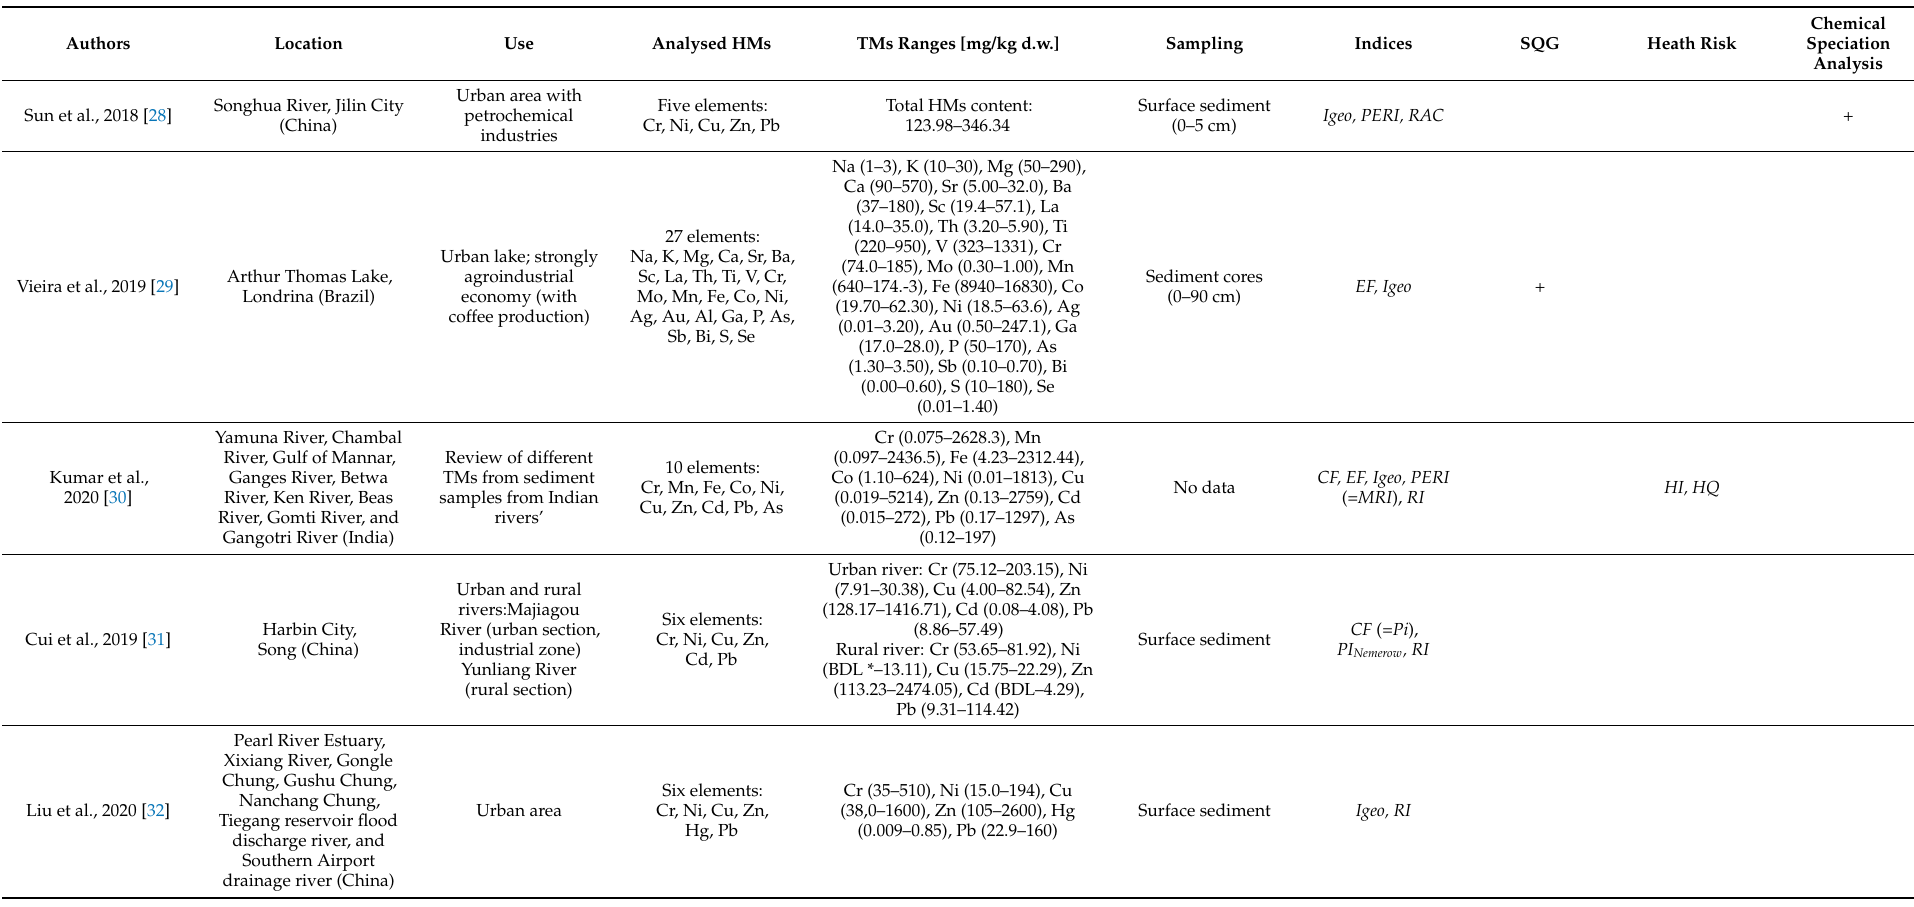
Table A1. Comparison of trace elements investigated in bottom sediments of diverse urban water bodies (river, lakes, receivers, retention tanks, etc.) with concentration ranges in mg/kg d.w., indication of indices used for pollution evaluation, classifications, and verification of health risks and an indication of the use of metal